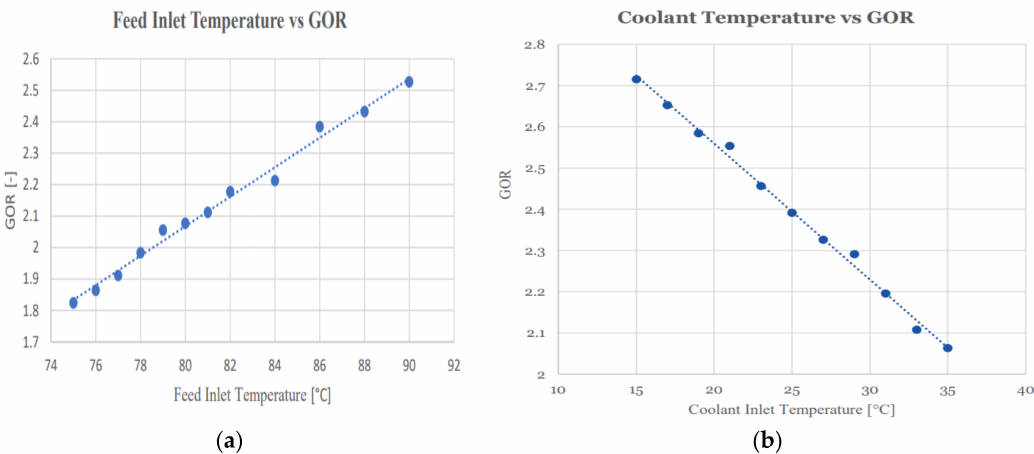
Figure 7. Effects on increasing feed/coolant inlet temperature versus GOR: ( a ) Effects on increasing feed inlet temperature vs. resulting GOR. ( b ) Effects on increasing coolant inlet temperature vs. resulting GOR.